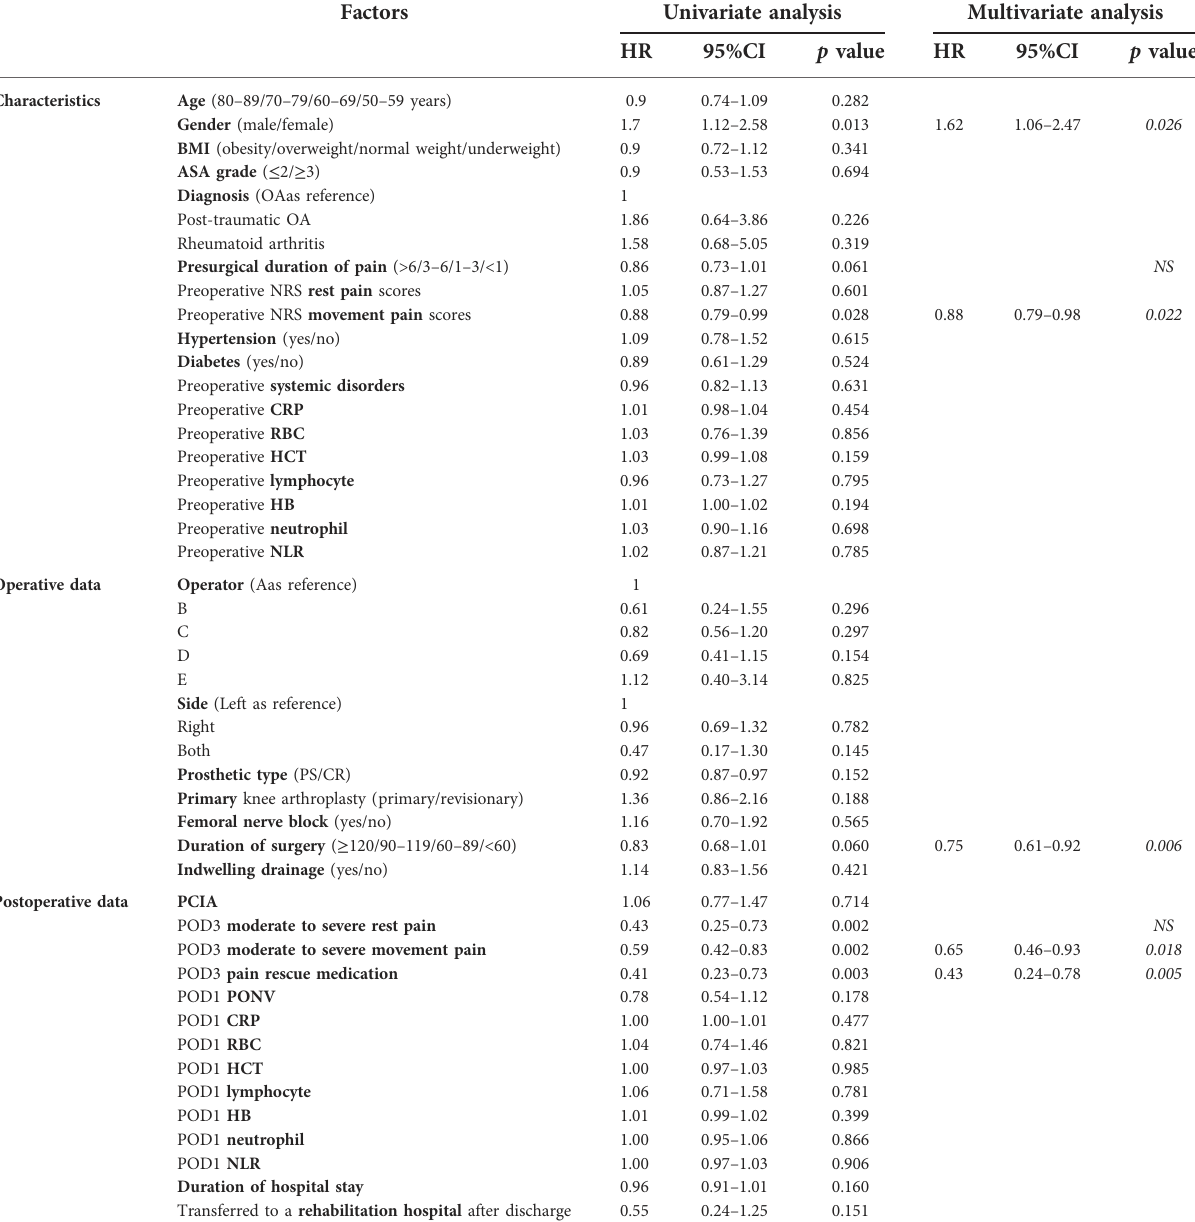
TABLE 4 Cox proportional hazards regression model of PAU.